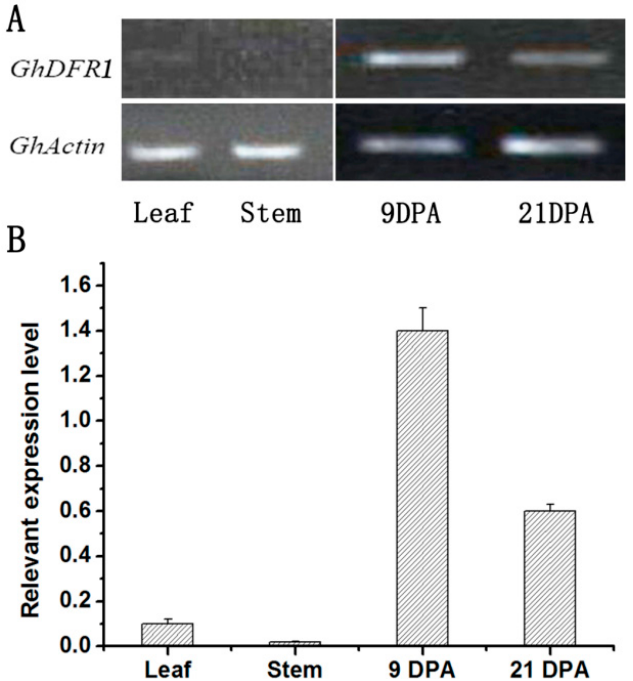
Figure 3. GhDFR1 expression pattern in cotton. ( A , B ): Semi-RT-PCR ( A ) and qPCR ( B ) results show expression levels of GhDFR1 at stem and leaf tissues, and two points developing fiber in G. hirsutum . DPA: day after flower fiber; Actin : β -actin as reference gene.